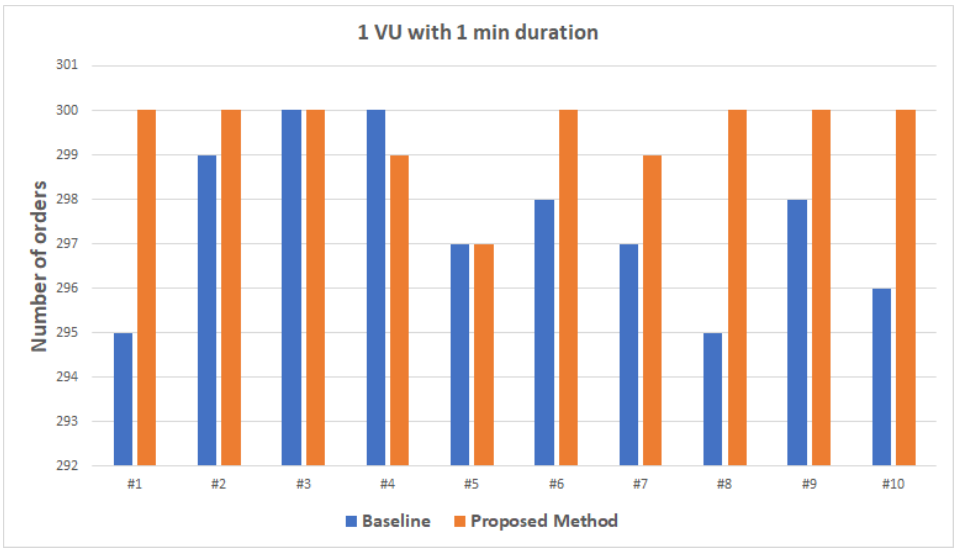
Figure 13. Load Testing—1 virtual user with 1 min duration.